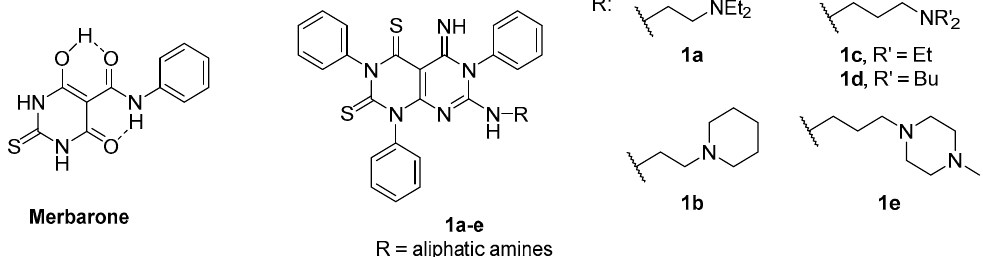
Figure 1. Chemical structures of merbarone and its rigid analogues 1 .